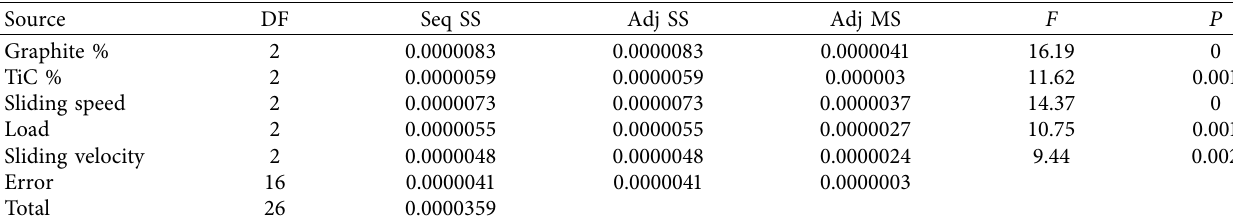
Figure 2: S/N ratio for wear Table 4: ANOVA for wear loss.